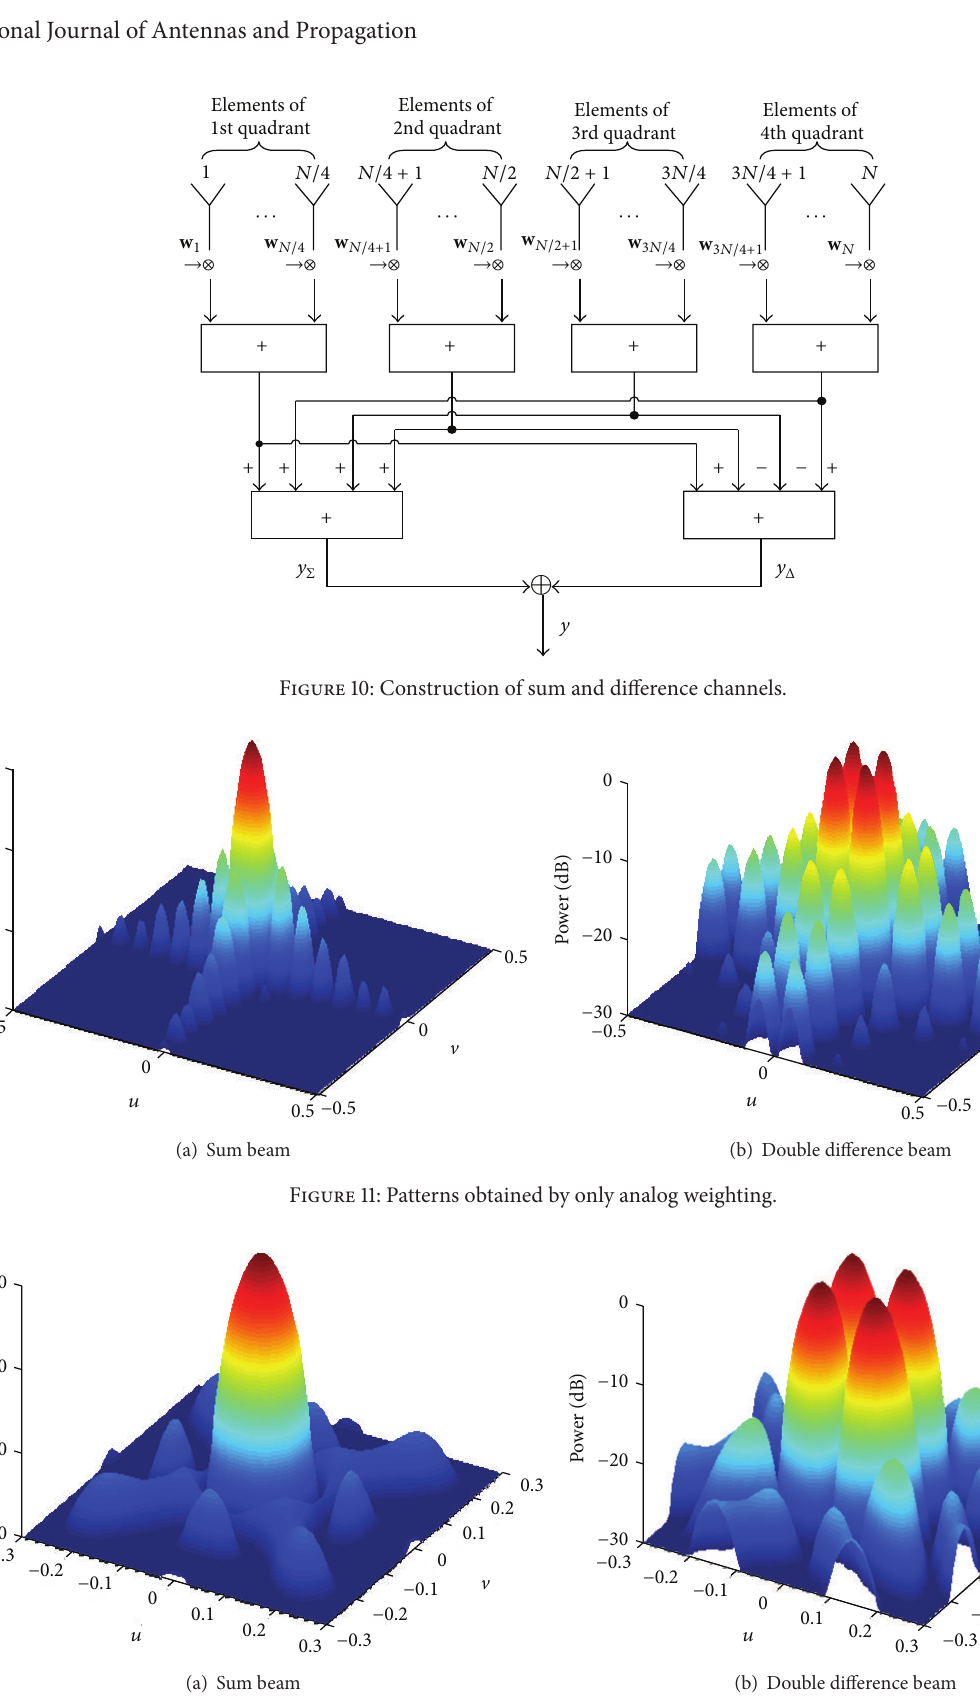
Figure 12: Patterns obtained by analog and digital weighting (with weight approximation